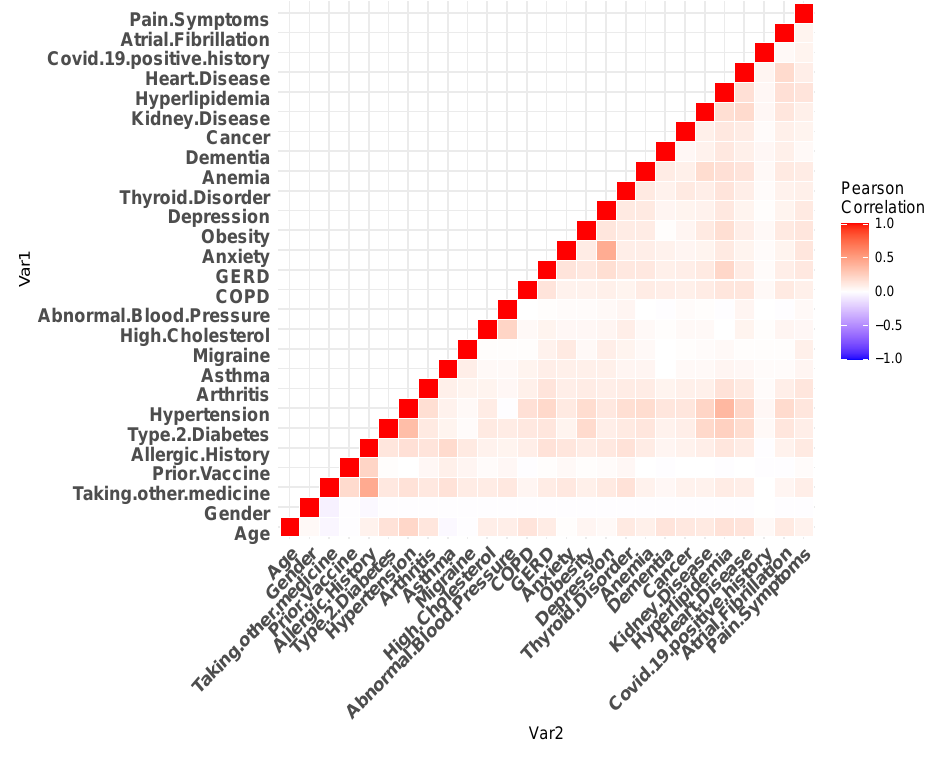
Figure 2. Pearson’s correlation heat-map for the dataset medical history.